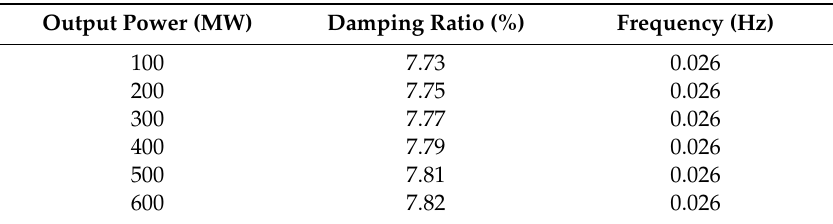
Table 3. Damping ratio and frequency with increasing of PV output power.